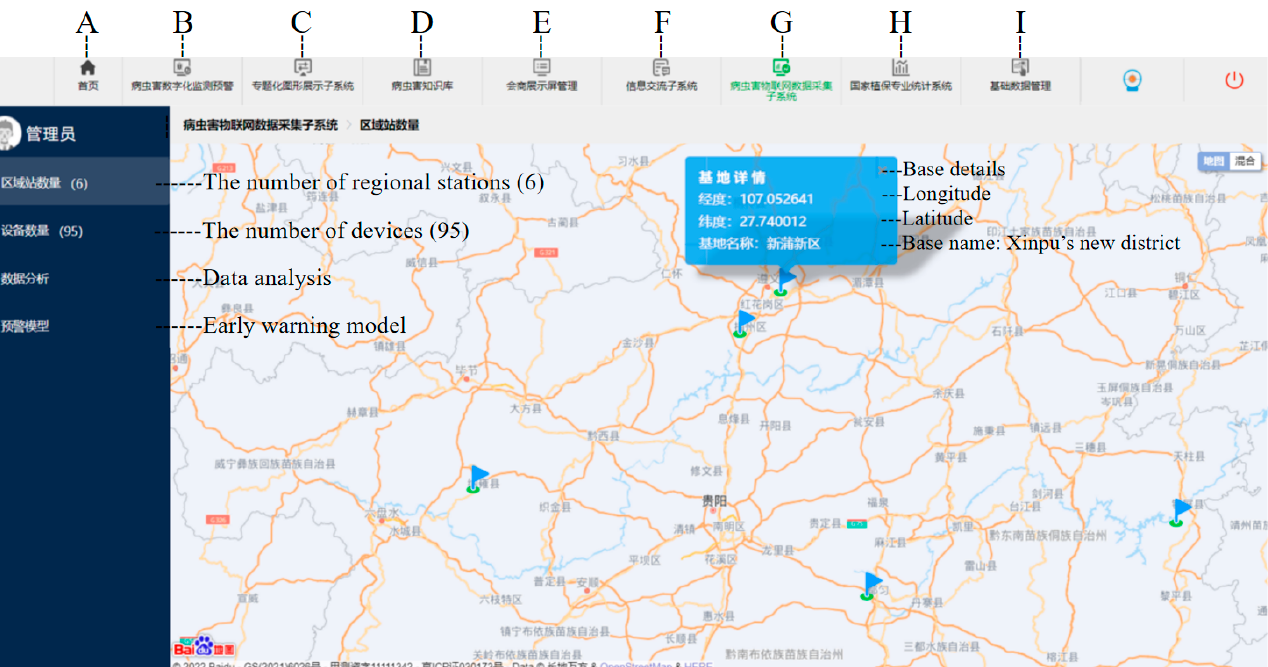
Figure 6. Interfaces of the epidemic monitoring system for hot pepper in Guizhou. (A) Front page; (B) Digital monitoring and early warning for disease and pests; (C) Thematic graphic display sub- system; (D) Disease and pest knowledge base; (E) Conference display management; (F) Information communication subsystem; (G) IoT data collection subsystem for disease and pests; (H) National plant protection professional statistical system; and (I) Basic data management.